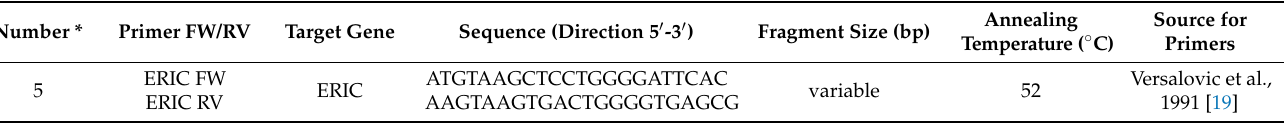
Table 6. Target gene, fragment size, and annealing temperature of the primers used for ERIC-PCR.